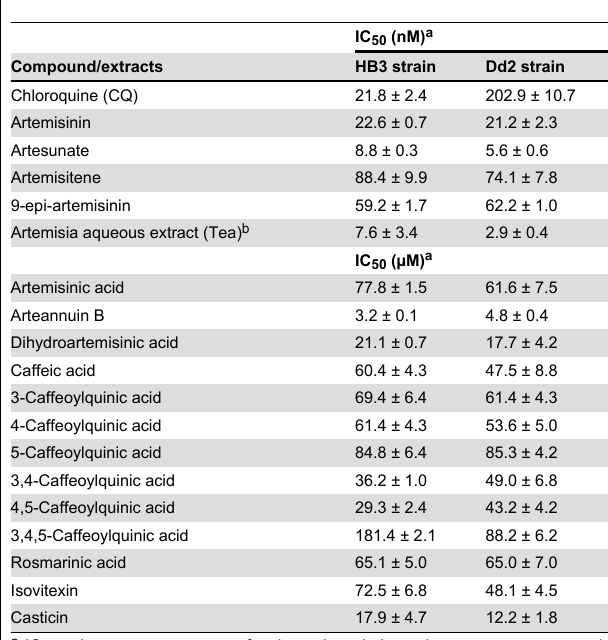
Table 1. Metabolites in the aqueous A. annua extract analysed by both MS/MS and HPLC methods quantified as milligrams per litre of tea.